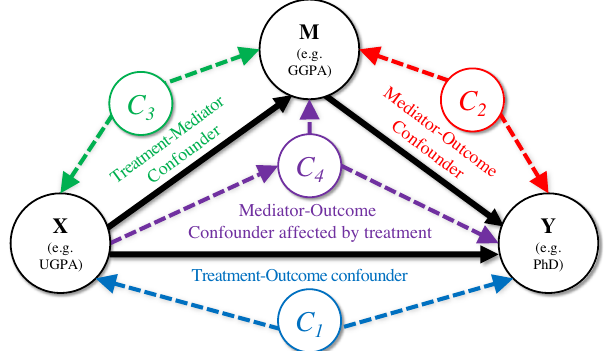
FIG. 5. Mediation diagram showing the relationship of con- founding variables C 1 − 4 to the variables of interest X , Y , and M . To satisfy the underlying assumptions of causal mediation analysis, researchers must account for these confounding vari- ables in their regression